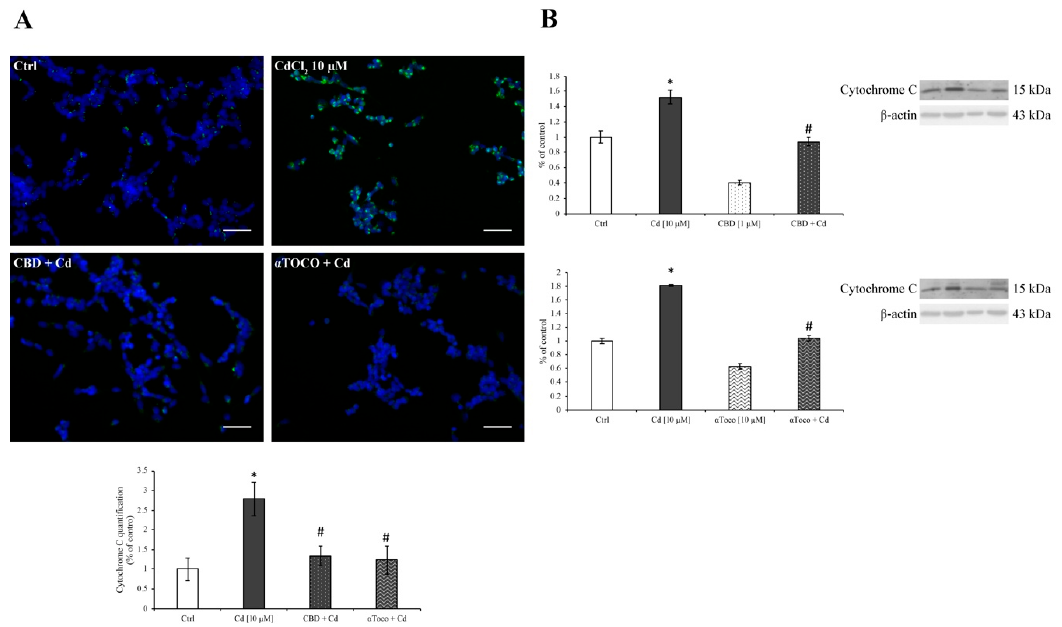
Figure 5. Cytochrome C expression on SH-SY5Y . ( A ) Immunofluorescent images of cytochrome C are shown. During CdCl 2 treatment, a conspicuous increment of cytoplasmic cytochrome C was observed. In contrast, the presence of CBD or α Toco prevented such an increase in the cell soma. These results were also highlighted by the histogram. ( B ) Cytochrome C expression levels evaluated by western blotting analysis. As reported, CdCl 2 (dark columns) treatment significantly increased the protein expression after 24 h of treatment. On the other hand, CBD (dotted dark column) or α Toco (wavy dark column) retained cytochrome C up-regulation. Results are expressed as mean ± S.E.M. Control, untreated cells, were taken as 100%. The housekeeping β -actin protein was used as an internal control for protein normalization. Each experiment point was performed in triplicate, from three different sets of experiments. Total magnification: 200×. Scale bar: 50 μ m. * p < 0.05 vs. Ctrl; # p < 0.05 vs. Cd.